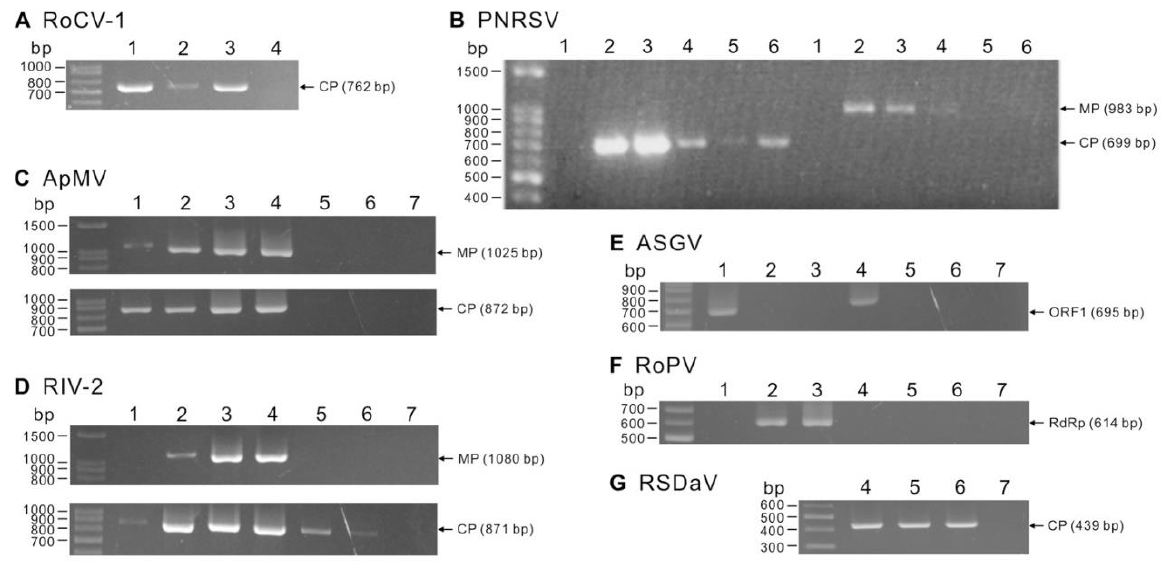
Figure 2. Detection of rose viruses by reverse transcription-polymerase chain reaction. ( A ) rose cryptic virus 1 (RoCV-1), ( B ) prunus necrotic ringspot virus (PNRSV), ( C ) apple mosaic virus (ApMV), ( D ) rose ilarvirus 2 (RIV-2), ( E ) apple stem grooving virus (ASGV), ( F ) rose partitivirus (RoPV), and ( G ) rose spring dwarf-associated virus (RSDaV) were detected in field-collected rose samples. Primers used for virus detection are listed in Table S1. Numbers represent sample code. The same samples were used to detect ApMV, RIV-2, ASGV, RoPV and RSDaV. Sample #4 in ( A ), sample #1 in ( B ), and sample #7 in ( C – G ) are asymptomatic rose leaves used as negative controls. The target genes and expected amplicon sizes are shown and indicated by arrows.